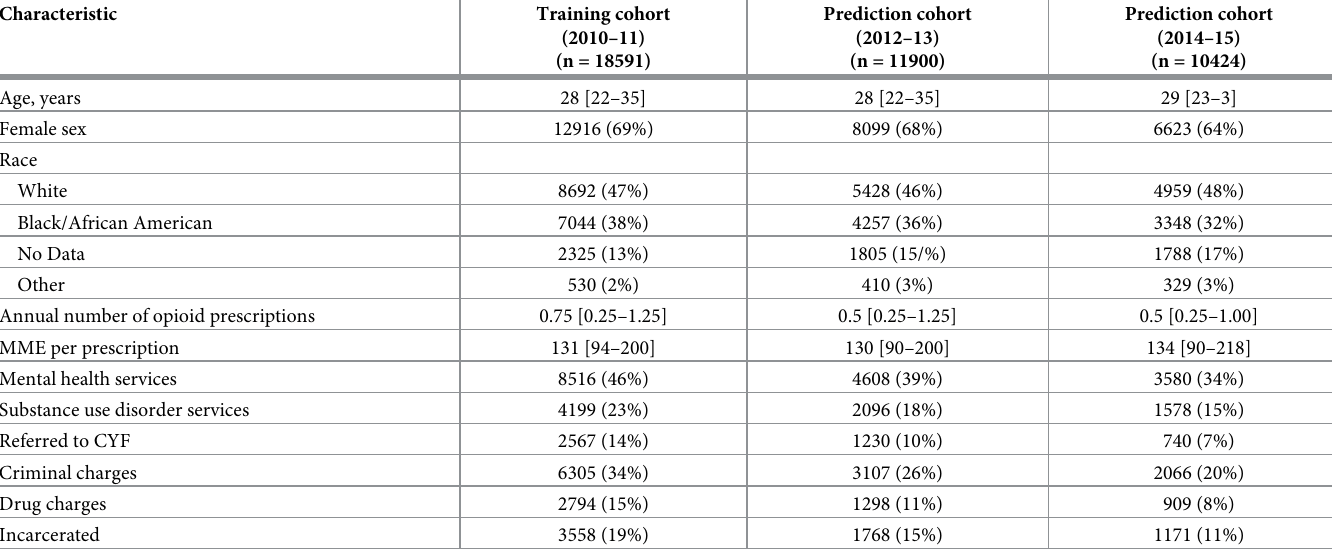
Table 1. Baseline population characteristics stratified by cohort, as determined by year of index opioid prescription.